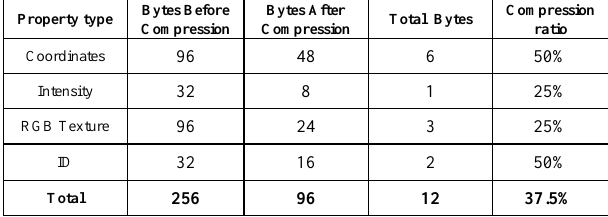
Table 1. Lossless compression statistics of point image